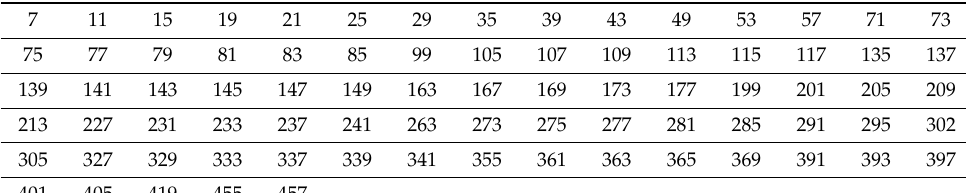
Table 5. x3 corresponding to block Q texture template